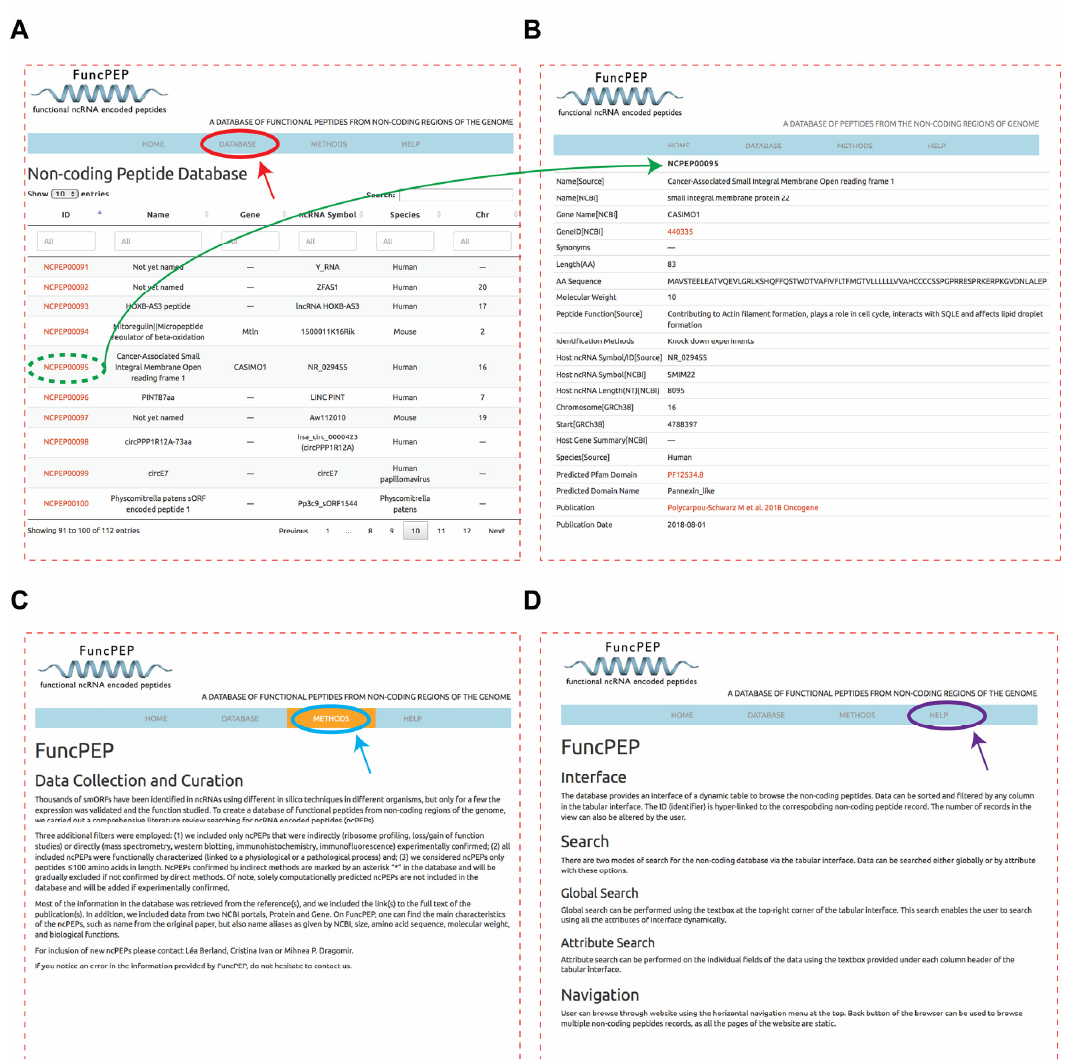
Figure 2. Database interface ( A ) The database section of FuncPEP providing an overview of